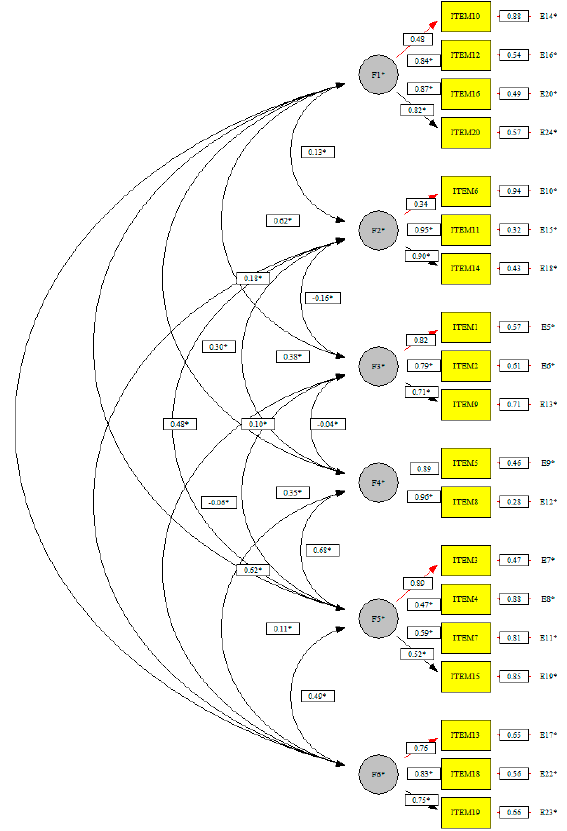
Figure 1. Graphical solution of CFA. Table 2. Descriptive statistics of the target